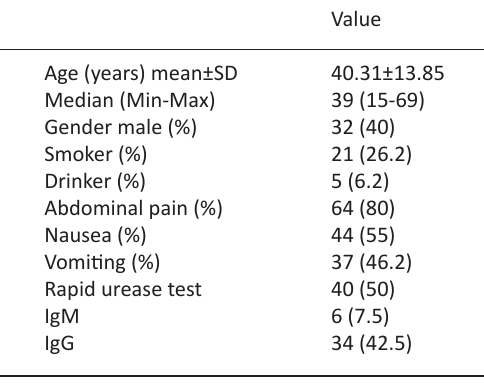
Table 1. Patients characteristics included in the study